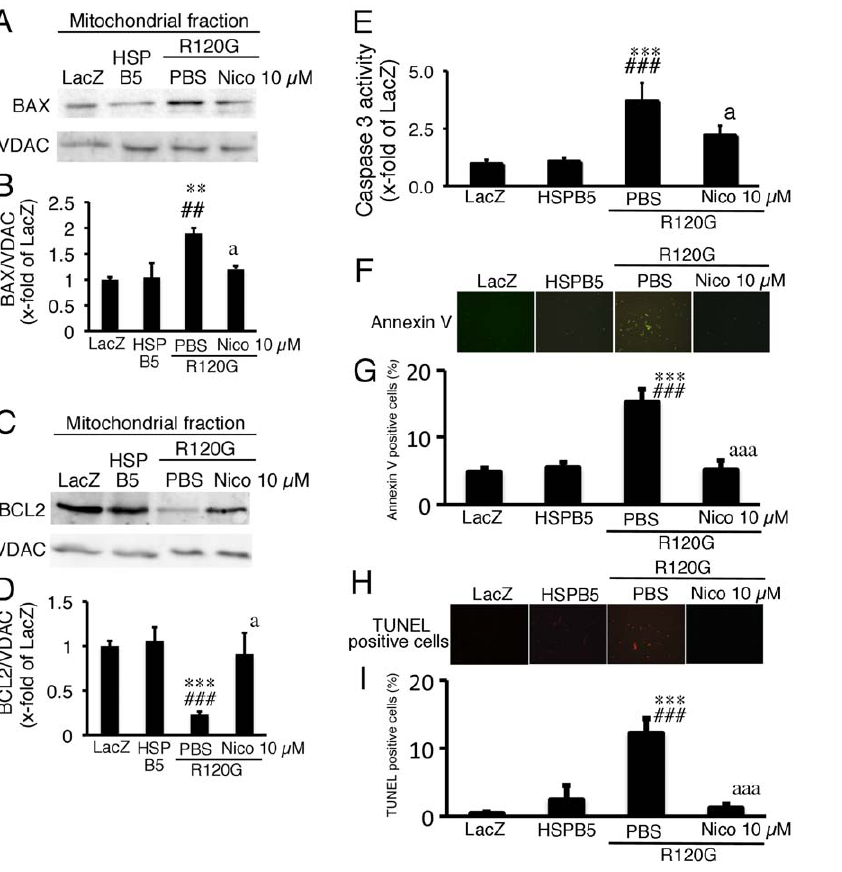
Figure 3. Western blot analysis of apoptosis related proteins, BAX and BCL2, and apoptotic cell death in the cardiomyocytes expressing HSPB5 R120G (R120G) with or without Nico treatment. (A) Typical pictures of Western blot analysis. (B) Quantitative analysis of BAX in mitochondrial fraction isolated from the cardiomyocytes. (C) Typical pictures of Western blot analysis. (D) Quantitative analysis of BCL2 in mitochondrial fraction isolated from the cardiomyocytes. (E) Caspase 3 activity in the cardiomyocytes. (F) Typical pictures of annexin V-positive cardiomyocytes. (G) Quantitative analysis of annexin V-positive cardiomyocytes. (H) Typical pictures of TUNEL-positive cardiomyocytes. (I) Quantitative analysis of TUNEL-positive cardiomyocytes. ** p , 0.01, ***p , 0.001 vs. the cardiomyocytes infected with LacZ (LacZ), ## p , 0.01, ### p , 0.001 vs. the cardiomyocytes infected with wild-type HSPB5 (HSPB5), ap , 0.05, aaap , 0.001 vs. cardiomyocytes infected with R120G treated with PBS.